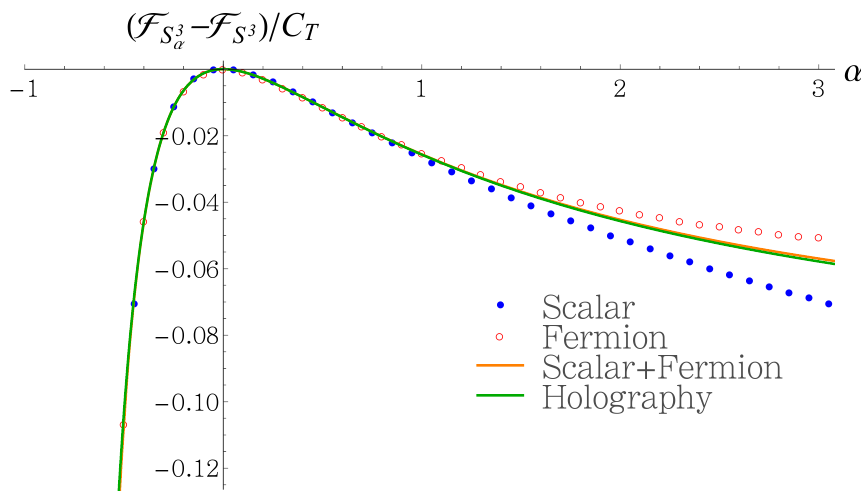
Figure 3 . The normalized free energy ( F (cid:11) in the range (cid:11) 2 [ (cid:0) 1 ; 3] for holographic theories dual to Einstein gravity (green solid line), a free scalar (blue dots), a free fermion (red dots) and the combination of both (orange solid line). the gravitational free energy (3.27), i.e., the free energy is extremized when the boundary is the round S 3